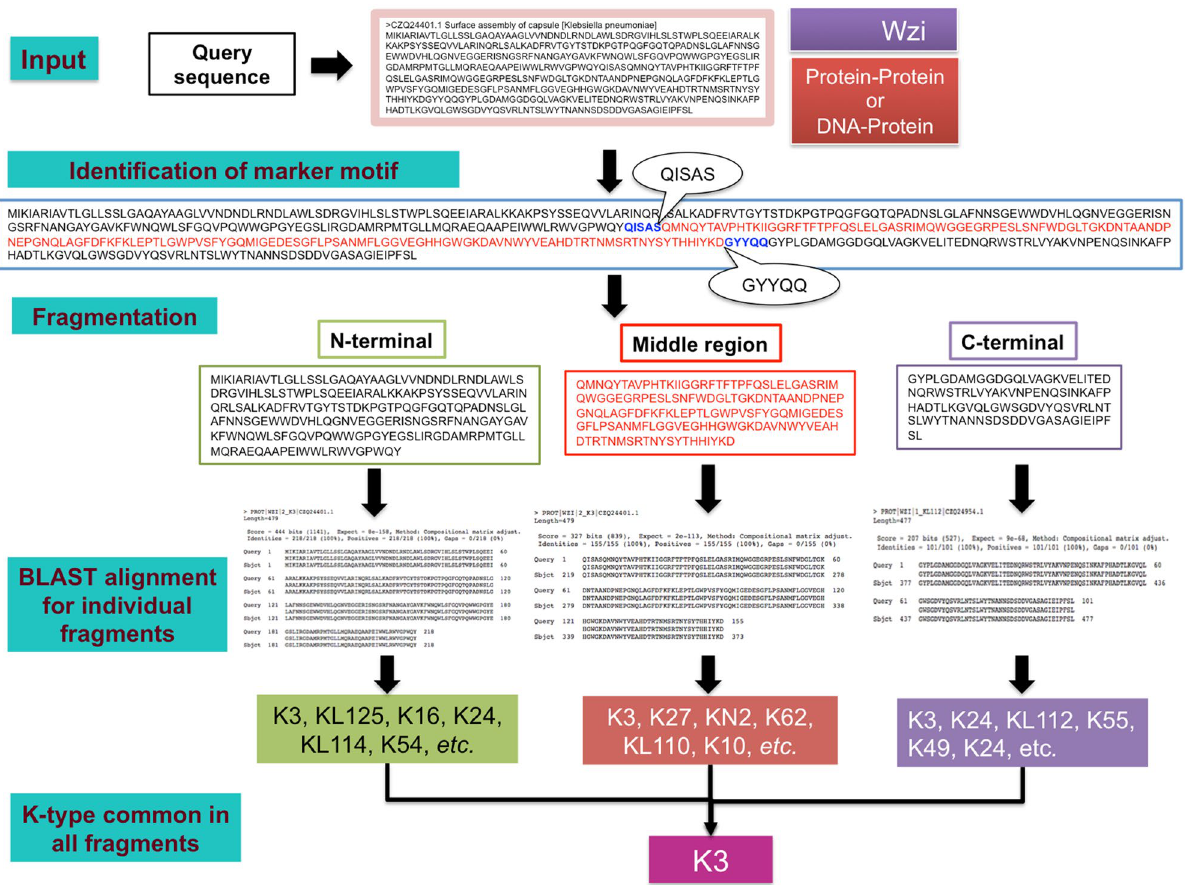
Figure 3. Fragment based serotype prediction method implemented for Wzi. Note that the whole query sequence gives multiple K-types (K3, KL130, KL137, K27, KL125, K62, etc.) for NCBI accession